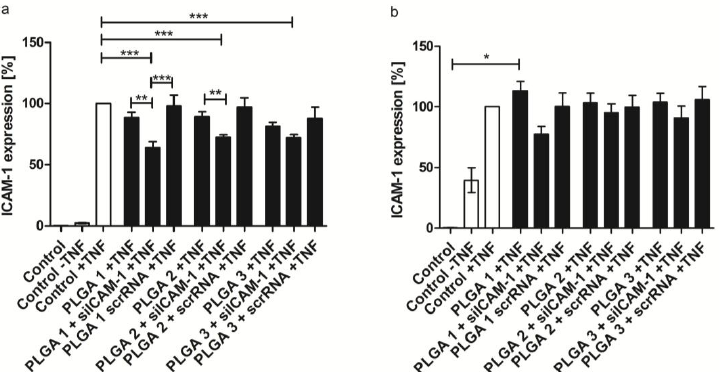
Figure 6. Gene knockdown of ICAM-1 after 48 h transfection by PLGA-coated slides examined by flow cytometry. ( a ) Expression of ICAM-1 in EA.hy926; ( b ) Expression of ICAM-1 in hVECs. EA.hy926 and hVECs were seeded one day before transfection with PLGA 1–3–coated glass slides in combination with either siICAM-1 or scrRNA or without additives, which served as a control.